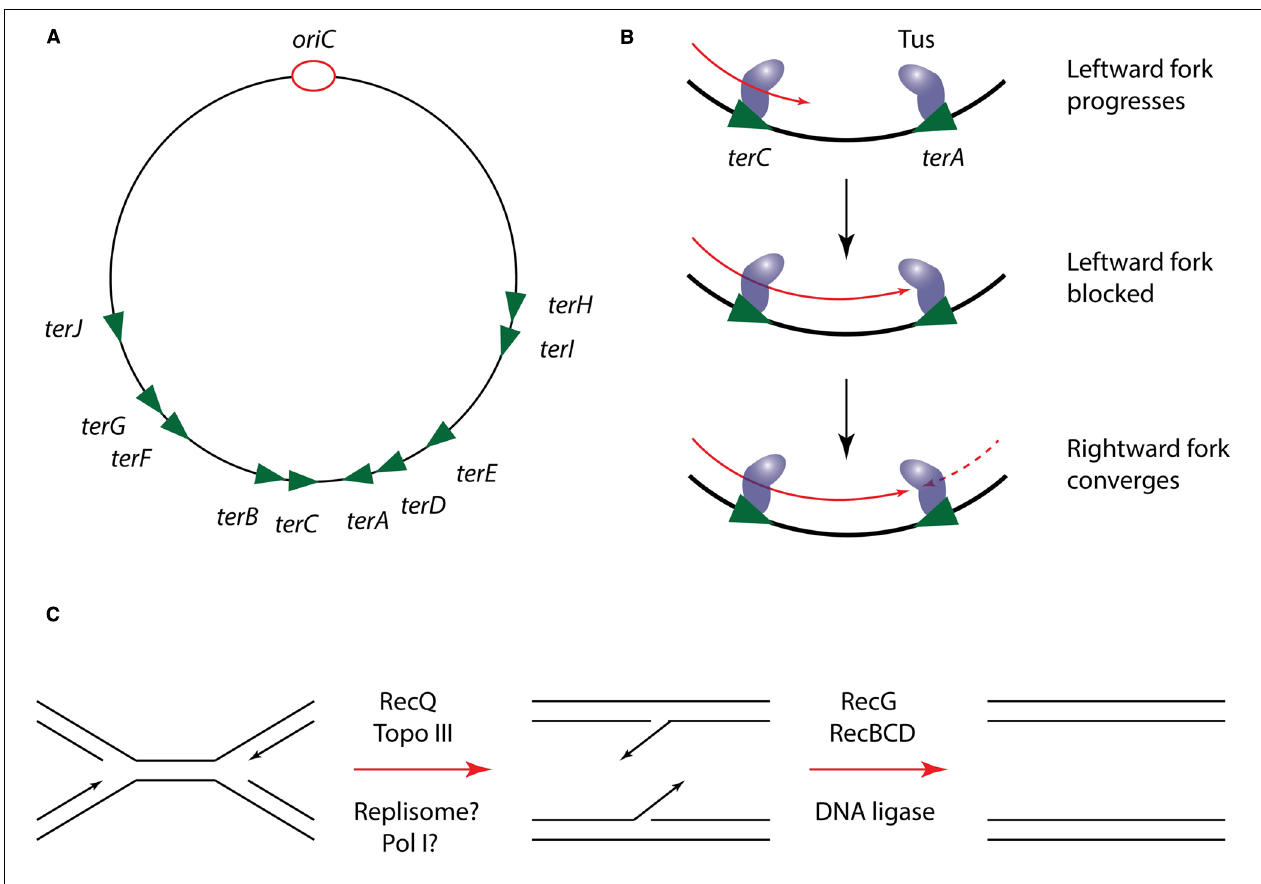
FIGURE 4 | Mechanism of replication termination in E. coli . (A) Schematic of the E. coli chromosome showing the approximate location of ter sites relative to oriC . Arrowheads indicate the permitted direction of replisome progression. Adapted from Duggin et al., 2008. (B) Mechanism